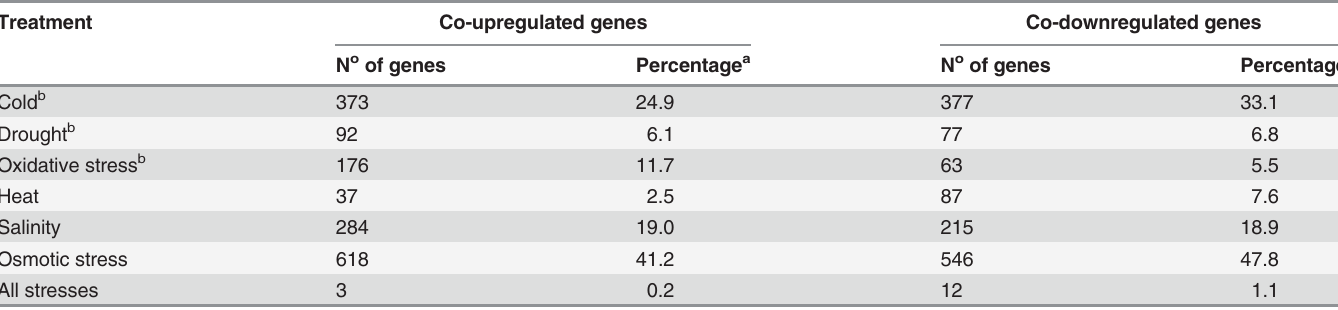
Table 1. Regulation of B . cinerea -regulated genes by different stimuli. Treatment Co-upregulated genes